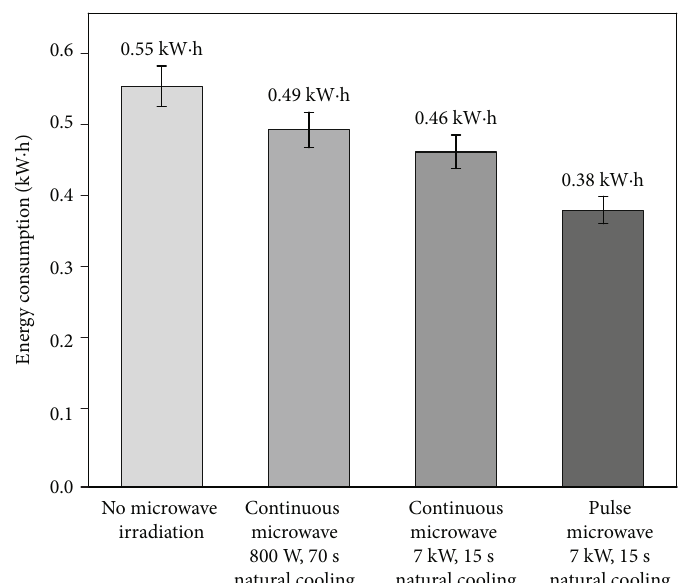
Figure 12: The total energy consumption of reaching the target fi neness for lead-zinc ore under di ff erent microwave pretreatment